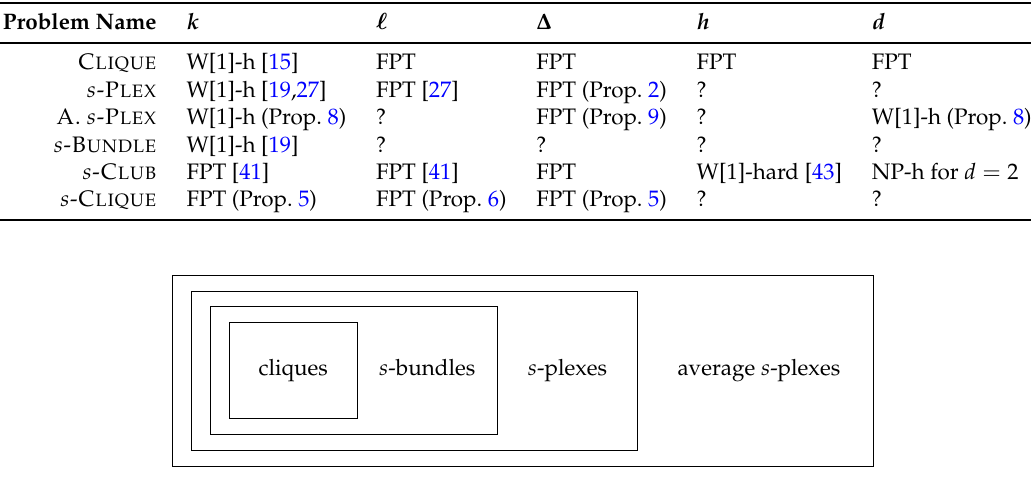
Figure 7. Inclusion diagram for (non-distance-based) clique relaxations using an absolute relaxation parameter s ; the inclusions hold for every fixed- s . For example, a 2-bundle is an average 2-plex. Table 2. An overview of the complexity of the subgraph problems for clique relaxations with relative relaxation parameter γ ∈ ( 0,1 ] . In all complexity results, γ is allowed to be a parameter of the algorithm; a question mark denotes that the complexity is open for this parameter. The abbreviations γ -RVCS and γ -RECS stand for γ -R ELATIVE -V ERTEX -C ONNECTED S UBGRAPH and γ -R ELATIVE -E DGE -C ONNECTED S UBGRAPH , respectively.